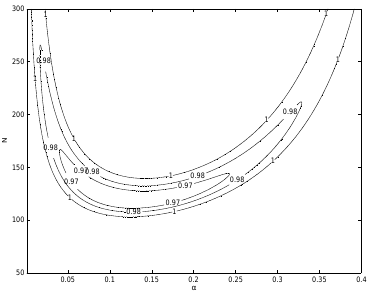
Figure 16. Contour plots of the objective function φ 2 ( α,N,m,ρ ) given by (5.3) for ρ = 2 , m = 6 and K = 100 .